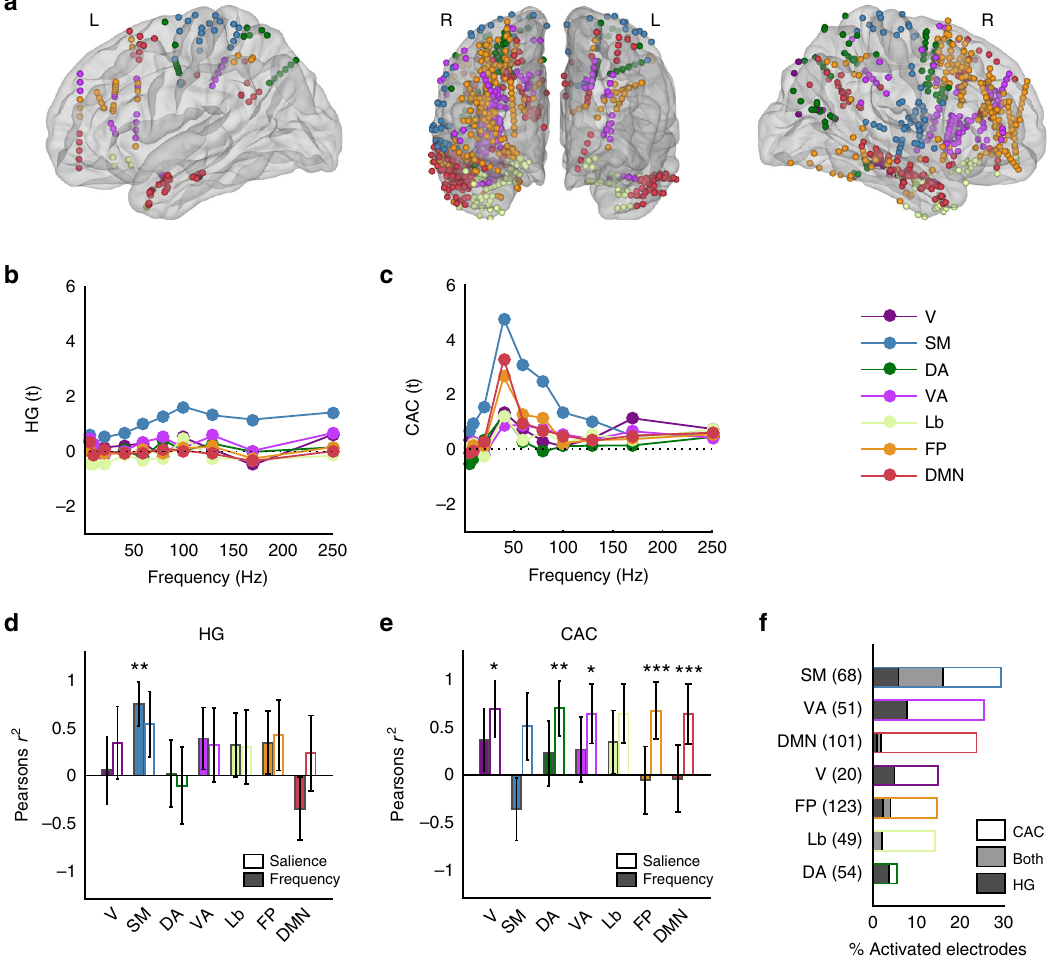
Fig. 6 HG and CAC response patterns in functional connectivity networks. a Anatomical and functional categorisation of electrodes based on functional connectivity networks: sensori-motor (SM); limbic (Lb), default mode (DMN), ventral attention (DA), fronto-parietal (FP) and dorsal attention (DA). b HG responses (expressed in t -values relative to the baseline) averaged within regions and across participants at each stimulus frequency. c Same as in ( b ) for CAC. d Pearson ’ s correlation value ( r 2 ) between onset HG responses and stimulus frequency (colour- fi lled bars) or salience (empty bars). Error bars indicate SE of the correlation. e Same as in ( d ) for CAC. f Proportion of activated electrodes exhibiting signi fi cant HG onset responses (dark shading), sustained CAC (no shading) or both (grey shading) in each network. Numbers in parentheses on the y -axis indicate the overall number of electrodes located in each network. *, ** and *** indicate signi fi cant (corrected) p -values at 0.05, 0.01 and 0.001,